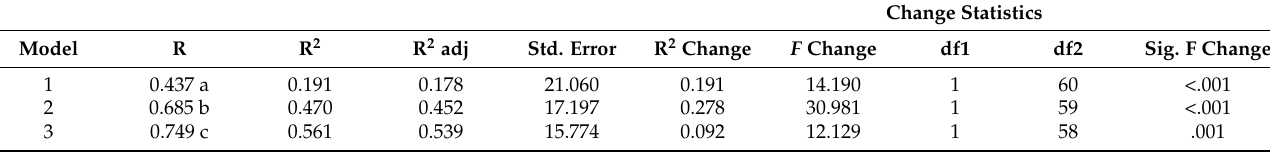
Table A6. Model summary for text fluency at T2.